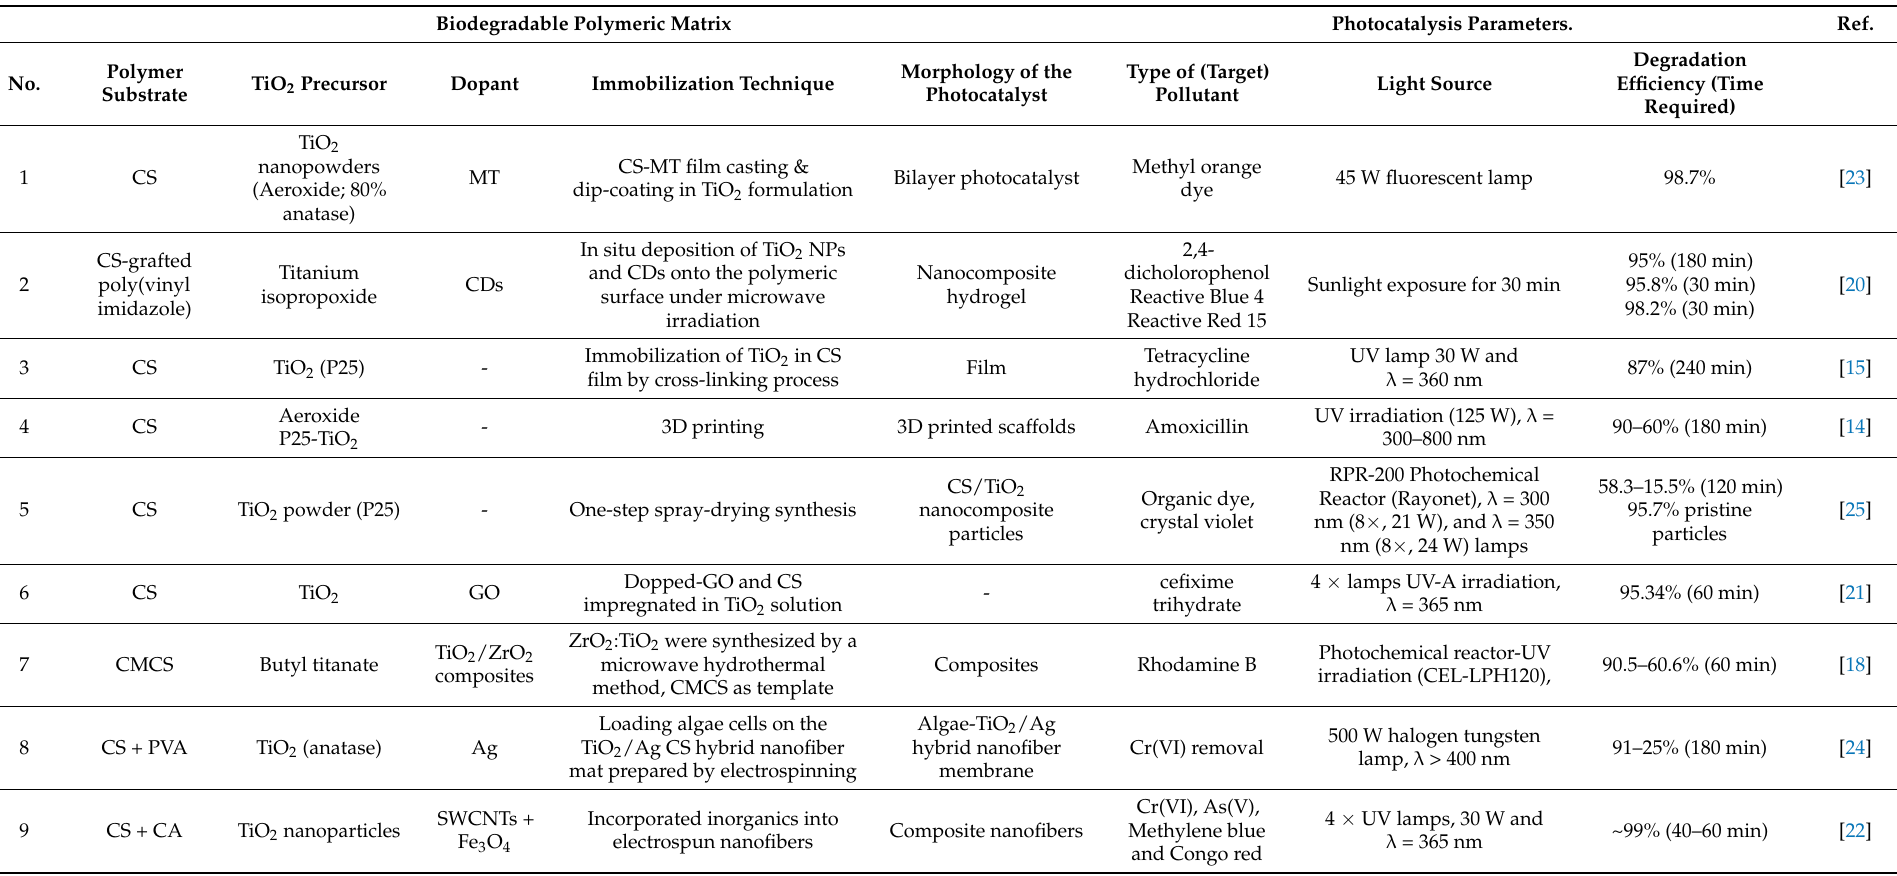
Table 1. Summary of the chitosan-supported TiO 2 photocatalysts enclosed in the presented literature. Biodegradable Polymeric Matrix Photocatalysis